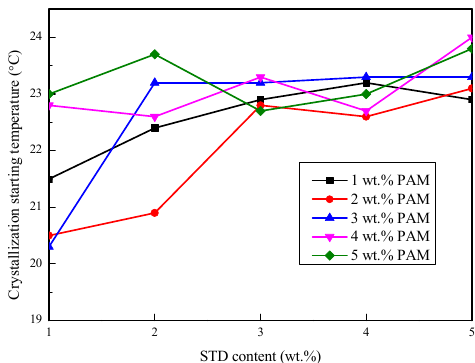
Figure 7. Effect of PAM and STD content on the crystallization starting temperature of the Na 2 SO 4 ·10H 2 O composites.